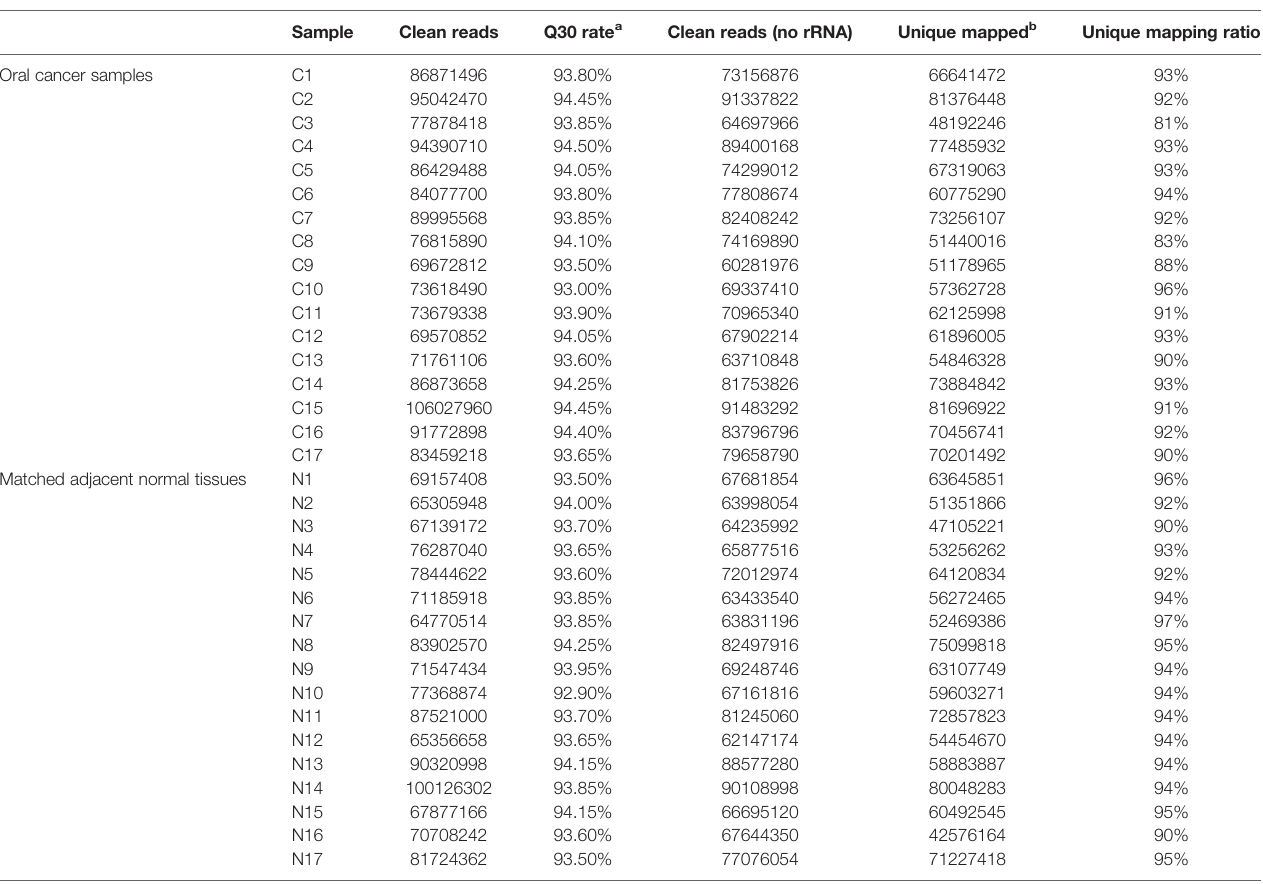
TABLE 2 | RNA sequencing pro fi